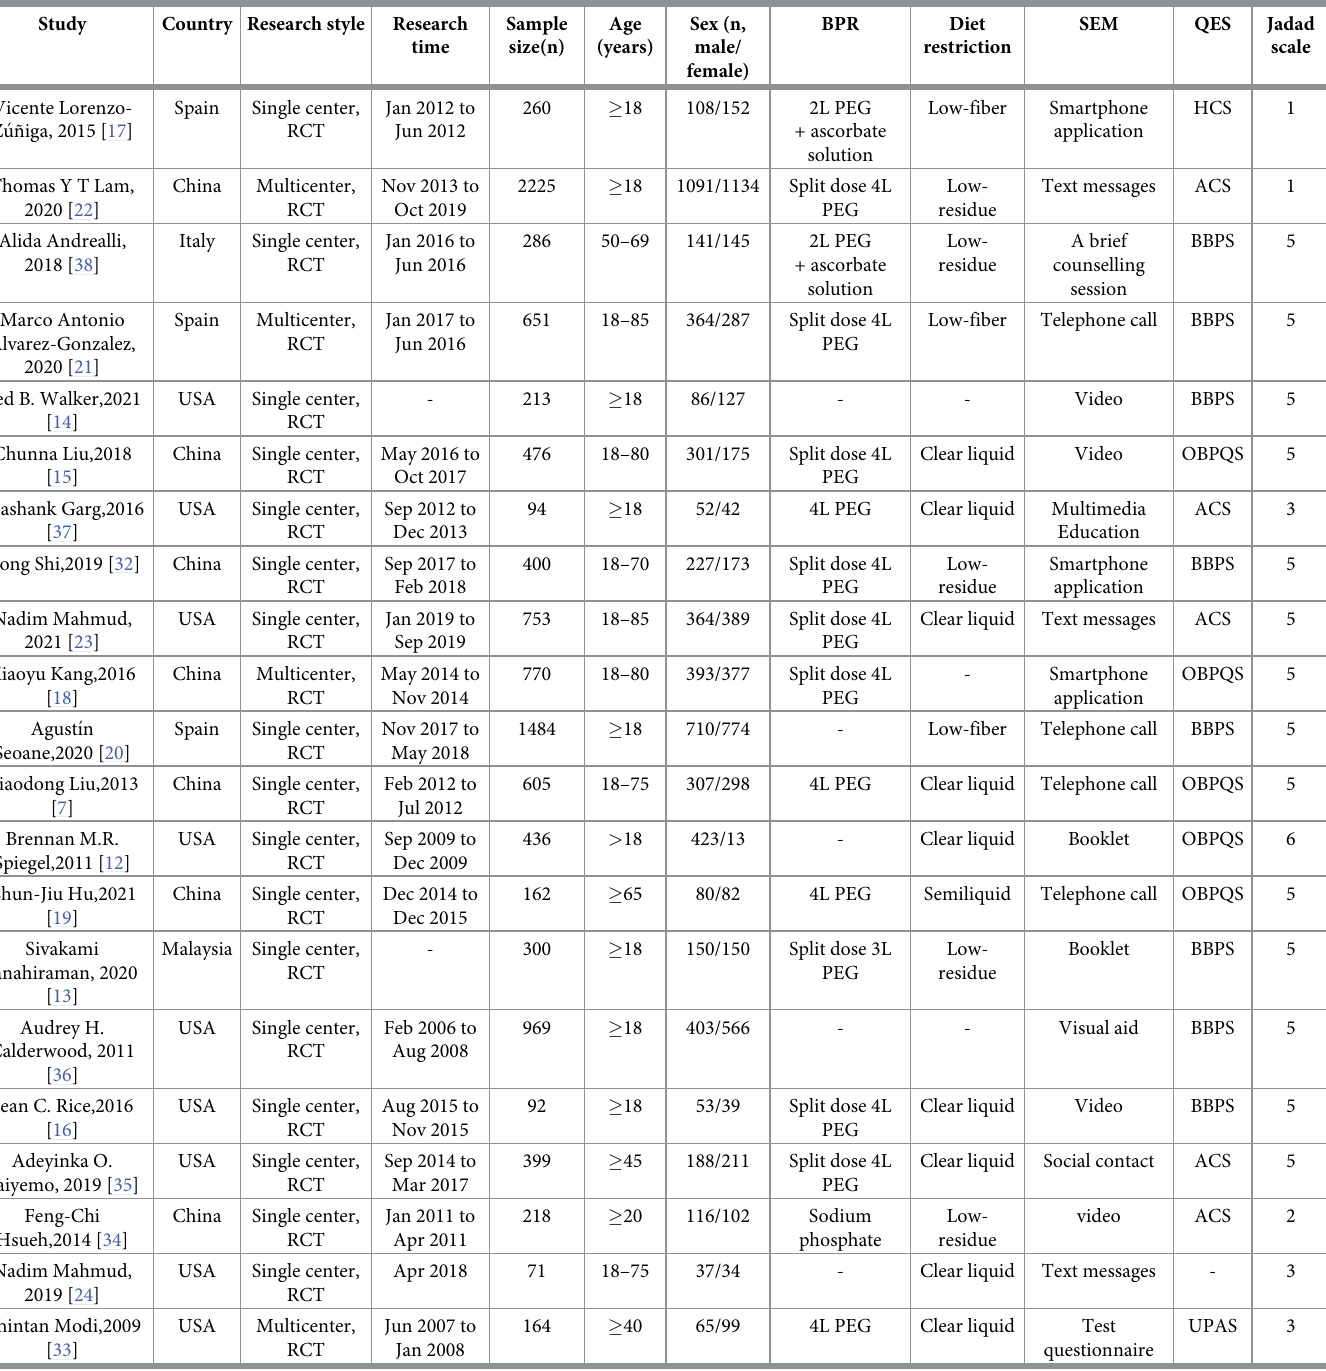
Table 1. Summary characteristics of studies included in the meta-analysis.